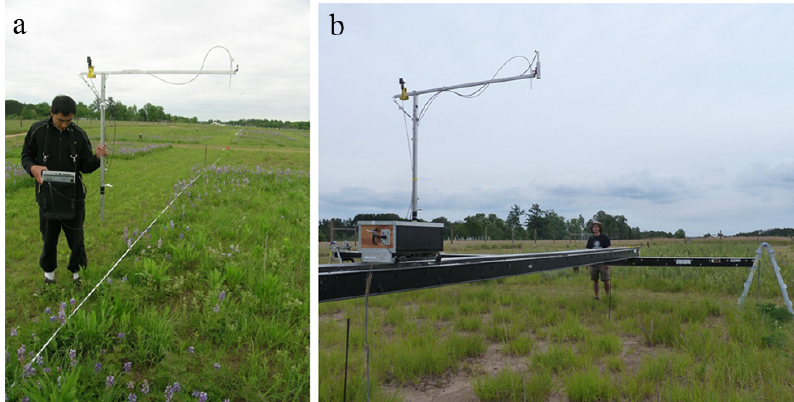
Figure 1. Sampling spectral reflectance using ( a ) the handheld method, applied biweekly to obtain reflectance phenology over the season; and ( b ) the tram cart on track [24] used to sample entire plots once near midsummer peak biomass. For the first method, only the northern-most row of each plot was sampled for reflectance phenology over the growing season. The second method is further illustrated in Figure 2.